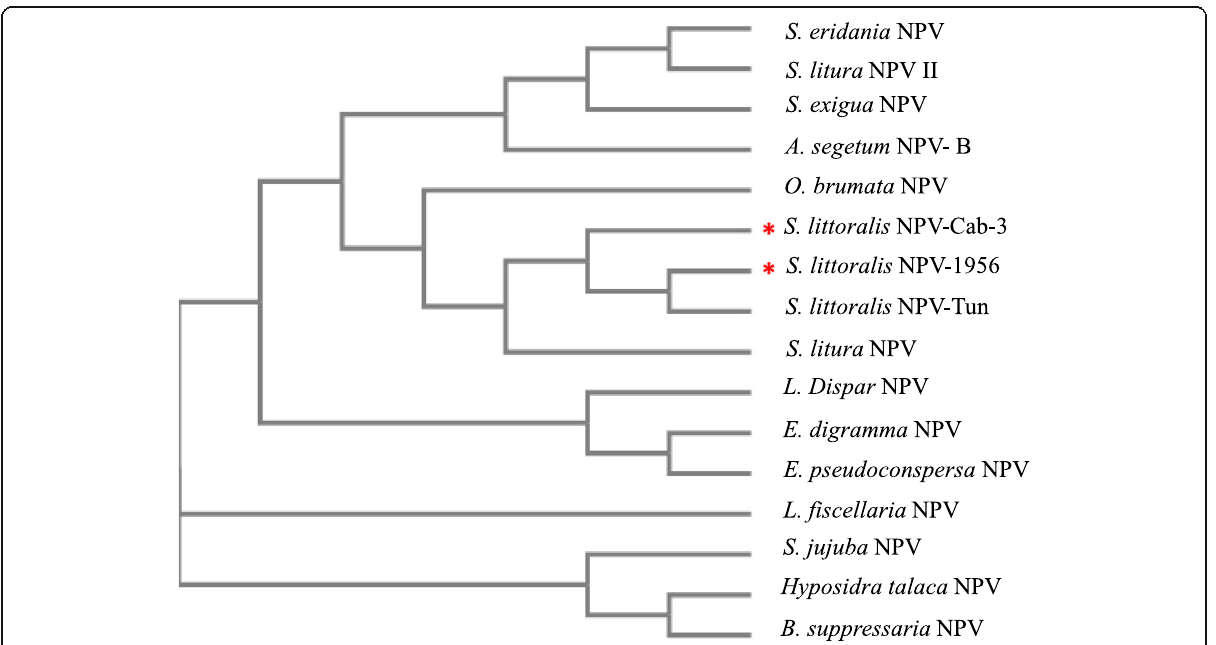
Fig. 3 Phylogenetic analysis of lef-5 deduced amino acids of SpliNPV-Cab3 isolate and the reference strain (R-strain) compared to published sequences. Multiple sequences alignment and phylogenetic tree were generated using Clustal Omega multiple sequence alignment program. Astrics indicated the SpliMNPV-Cab3 (Accession No: MW713059) and the reference strain SpliMNPV-AN1956 (Accession No: